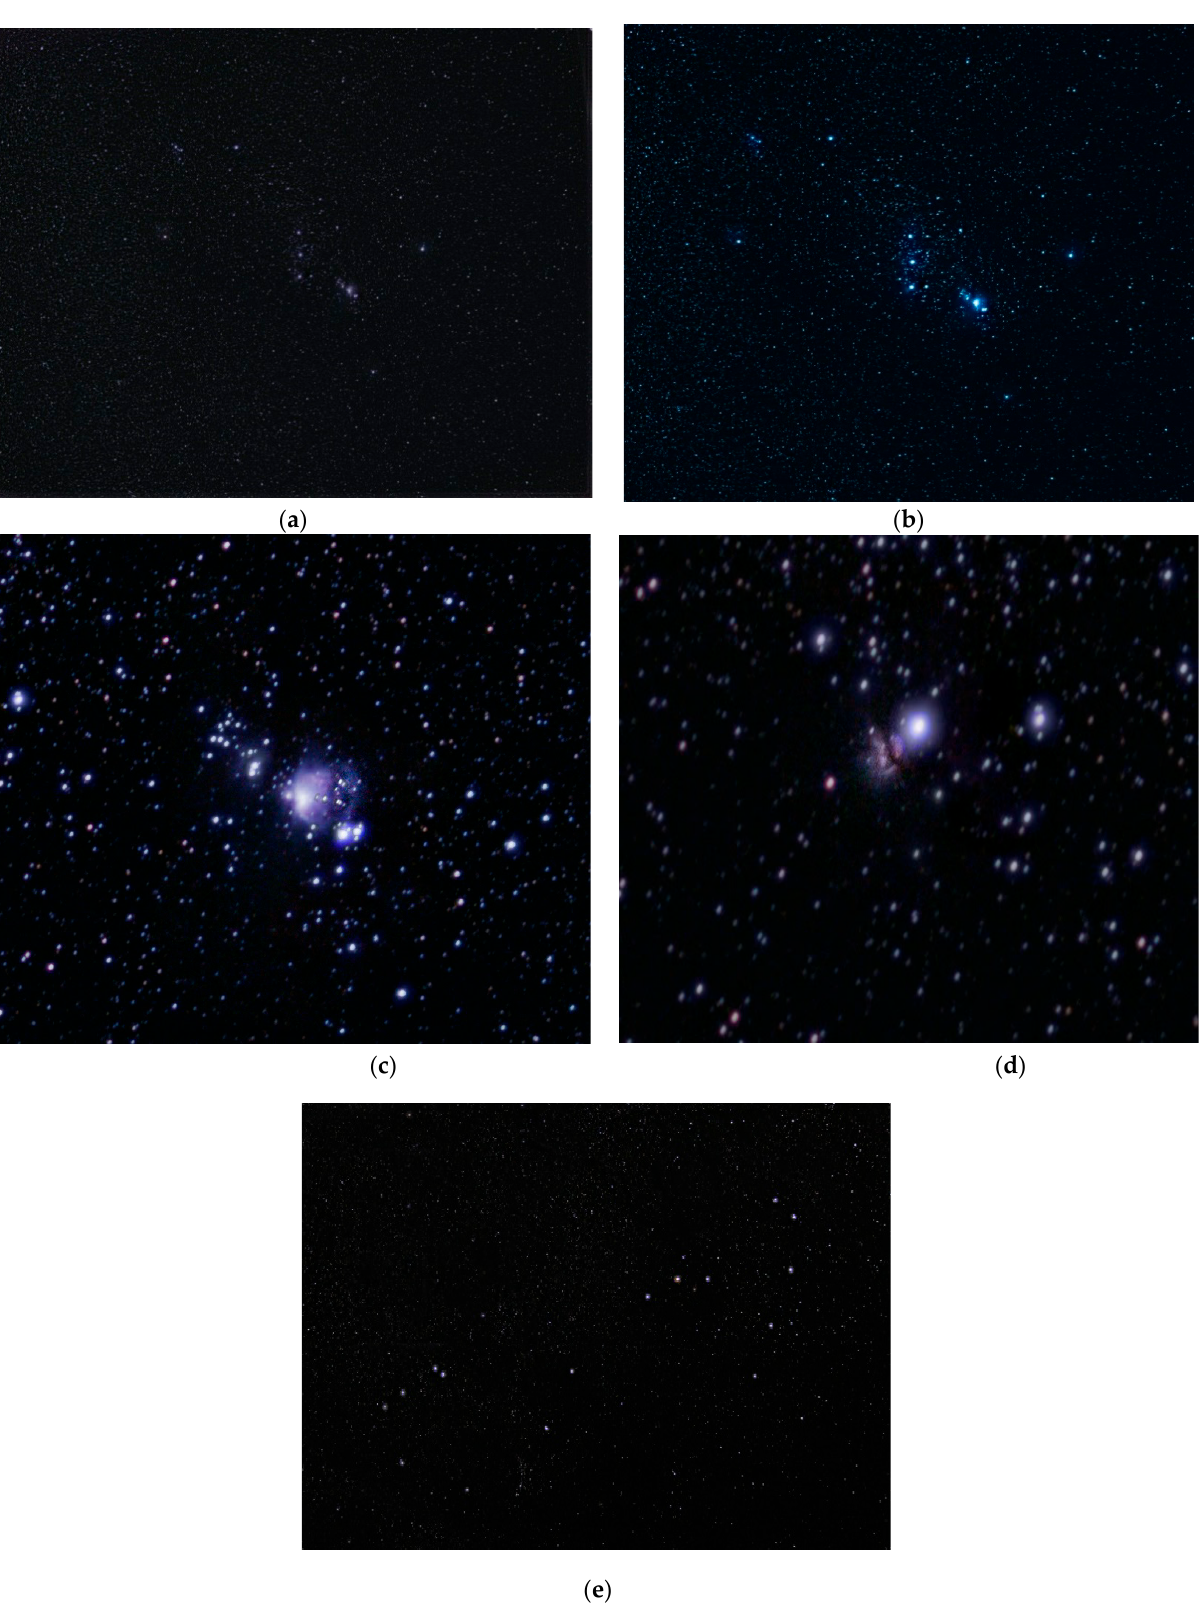
Figure 23. ( a ) Orion molecular complex 16-bit flat RGB image; ( b ) Orion molecular complex 8-bit enhanced color-graded image; ( c ) Orion Nebula flat 16-bit RGB image ( d ); Flame Nebula flat 16-bit RGB image; ( e ) Scorpius constellation down-sampled 8-bit RGB